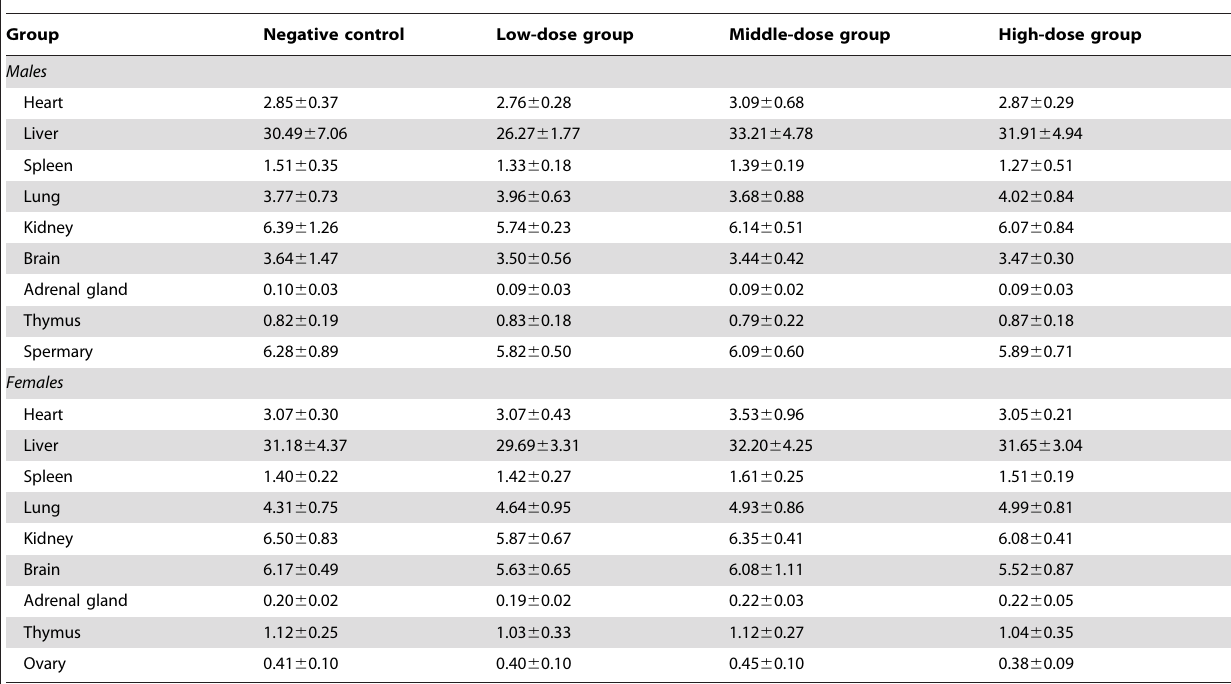
Table 9. Organ/body weight ratio( % ) of males and females (mean 6 SD, n=10).